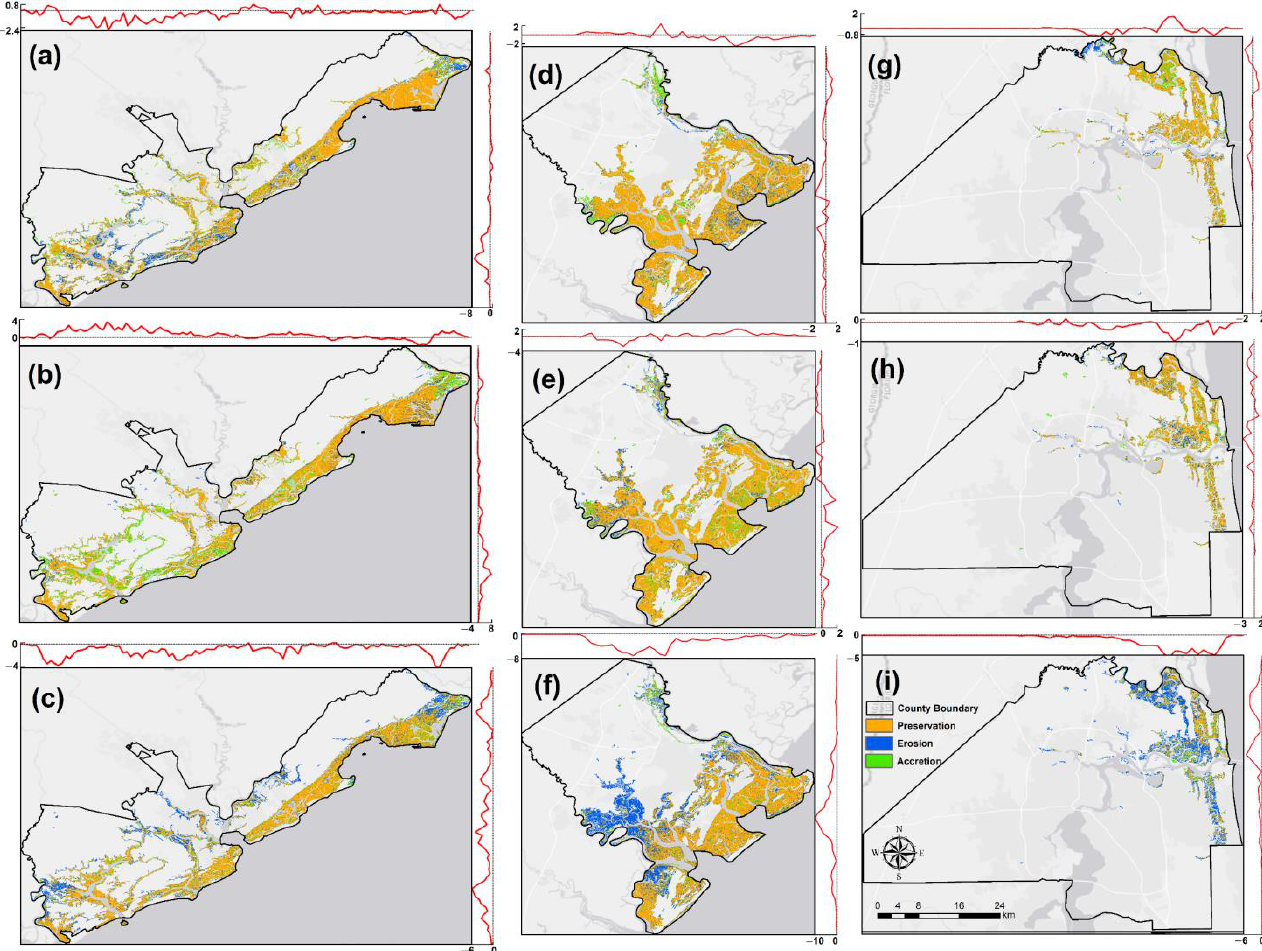
Figure 6. The spatial distribution of tidal flat area changes in Charleston, SC (leftmost column), Chatham, GA (middle column), and Duval, FL (rightmost column), between 1985 and 1995 (top row); 1995 and 2005 (middle row); and 2005 and 2015 (bottom row). The area changes (in km 2 ) summarized by latitudes and longitudes are visualized as line charts along map edges. (The World Light Gray Basemap is used as the background, which is provided by Esri, HERE, Garmin, © OpenStreetMap contributors, and the GIS User Community.)